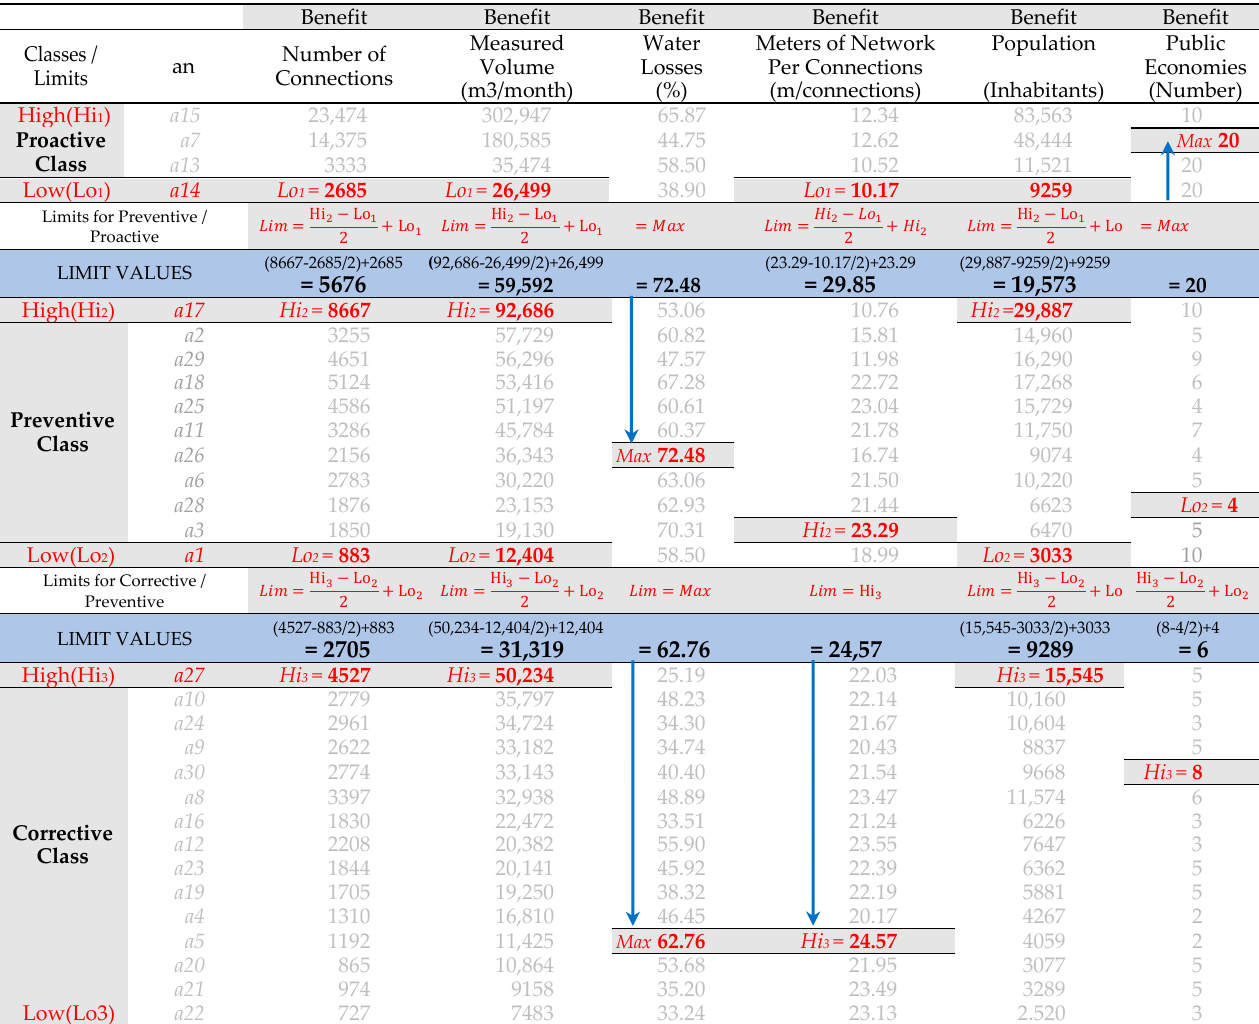
Table 8. Definition of limits after sorting by Clustering method—FCM—Procedure 1.